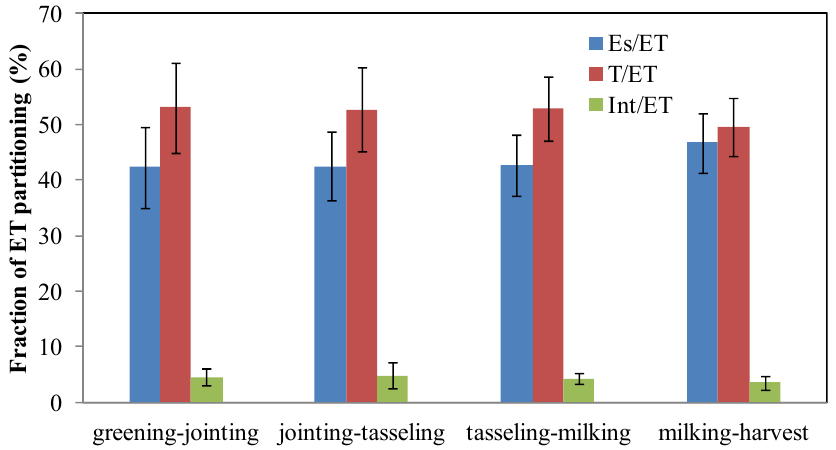
Figure 7. Fraction of ET partitioning in rainfed maize farmland during different maize growth stages.